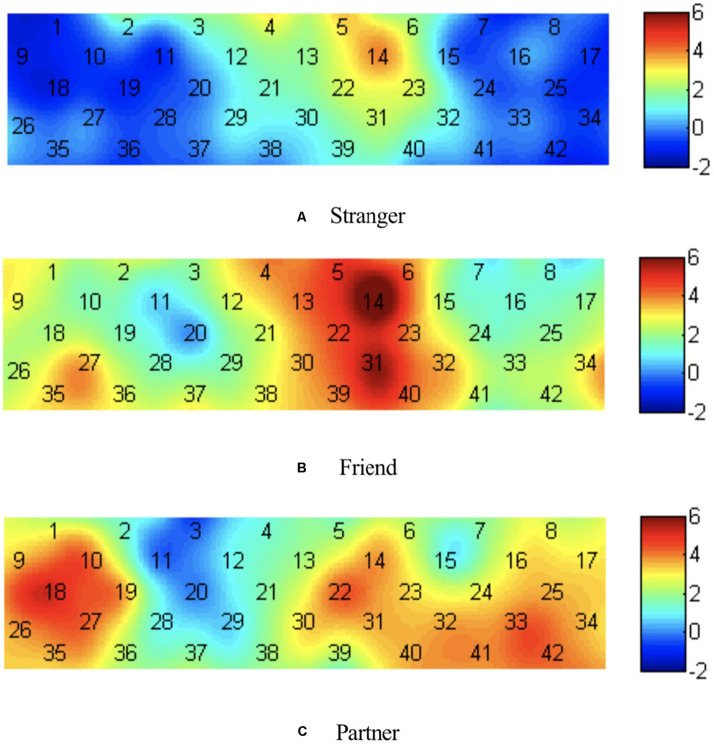
Heat map of t value for brain activation of different photographs. (A) Viewing stranger photographs; (B) viewing friend photographs; (C) viewing partner photographs.